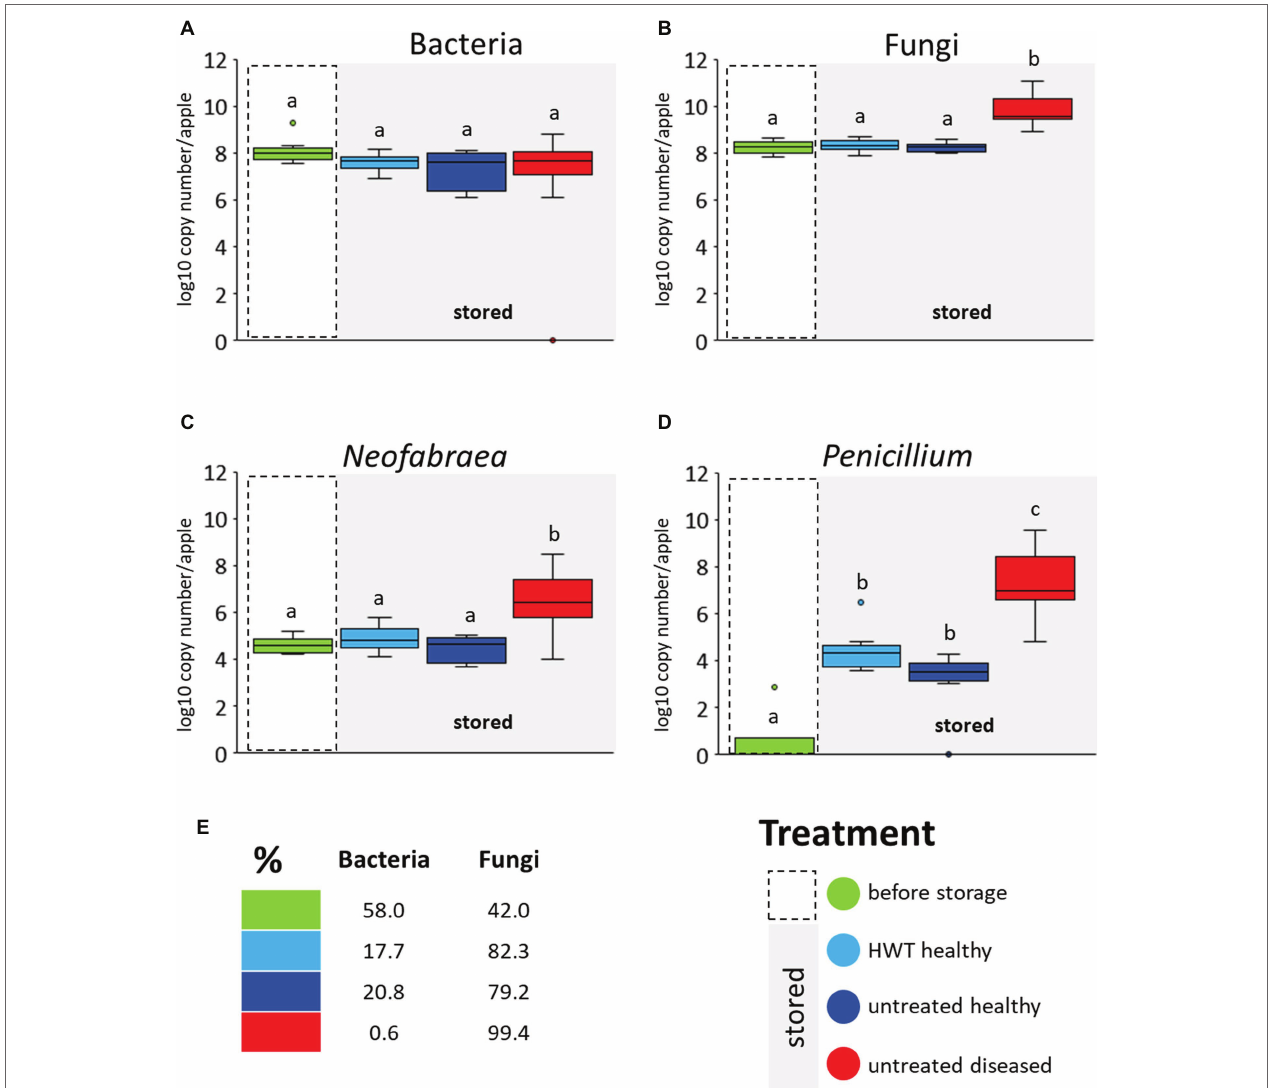
FIGURE 4 | Microbial gene copy numbers in apple groups determined by qPCR. Values are given by primers targeting bacterial 16S rRNA genes (A) , fungal ITS region (B) and genes of N. alba (C) and P. expansum (D) . Gene copy numbers are calculated per apple used for the microbiome analysis. Significant differences ( p ≤ 0.05) were assessed by Wilcoxon test (Bonferroni correction) and are indicated by different lower case letters. The prokaryote to eukaryote ratio within the total microbial gene copies detected in apples of the respective groups is shown (E) . Color code for apple groups is depicted in the legend on the bottom